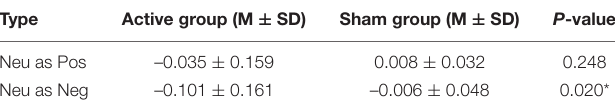
TABLE 3 | The commission errors rates of neutral standards differences before and after treatment between two groups.